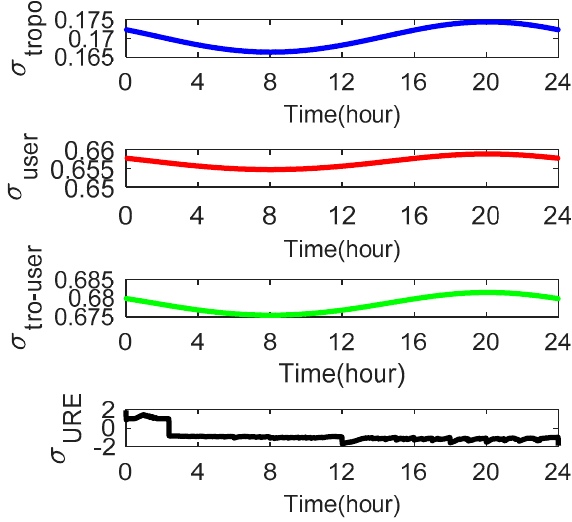
Figure 9. The tropospheric delays σ tropo,i , user errors σ user,i and σ URE of satellite C01 over one day as seen from the receiver at Wuhan University.